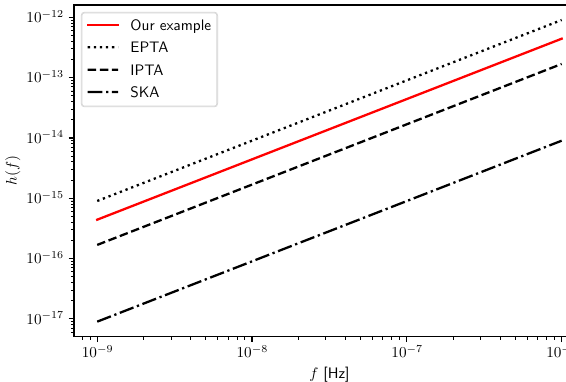
Fig. 3 Aplotof R 0 (θ (cid:14) ) = the leading order term in (48). Note that R 0 becomes maximum and minimum at θ (cid:14) = π + cos − 1